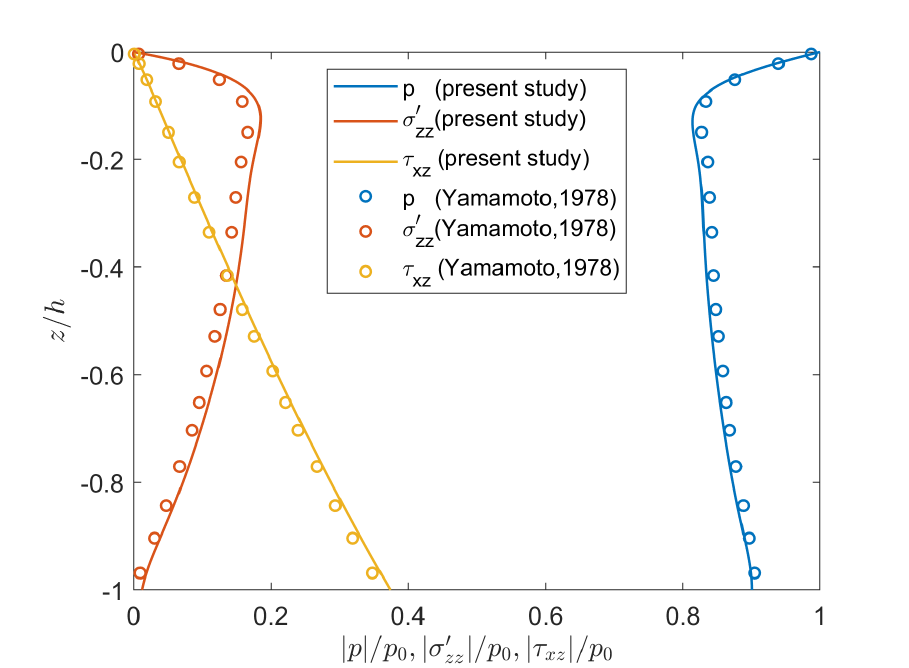
Figure 2. Amplitude profile of pore pressure p , vertical effective stress σ (cid:48) zz , and shear stress τ xz for the isotropic